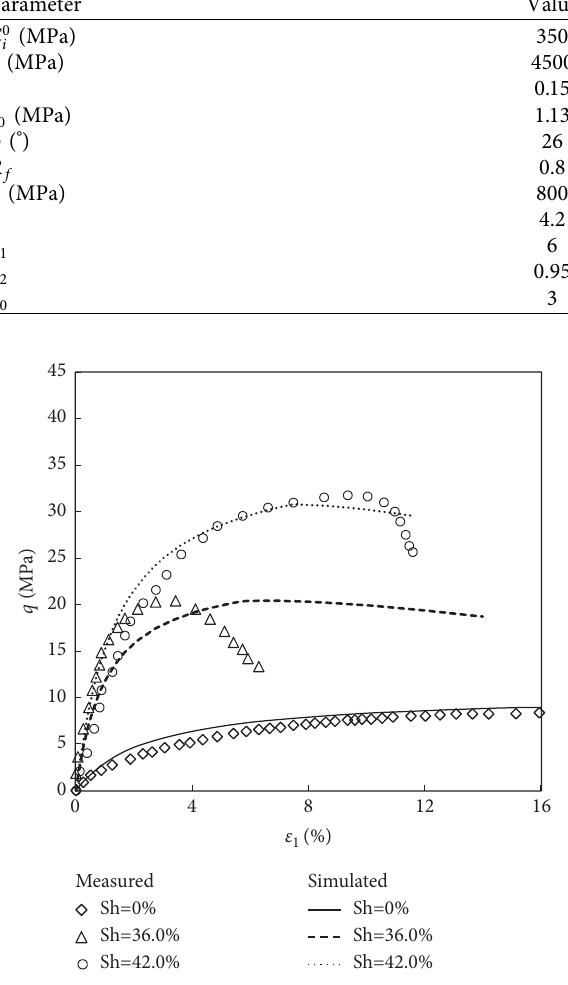
Figure 12: Comparisons of the calculated and experimental stress- strain curves for the hydrate-bearing sediment in the South China Sea